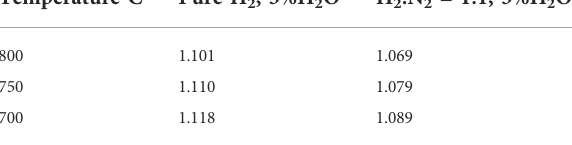
TABLE 1Nernstvoltage for hydrogenfuel(pure H 2 or H 2 :N 2 =1:1) with 3% moisture versus air at various temperatures. Temperature